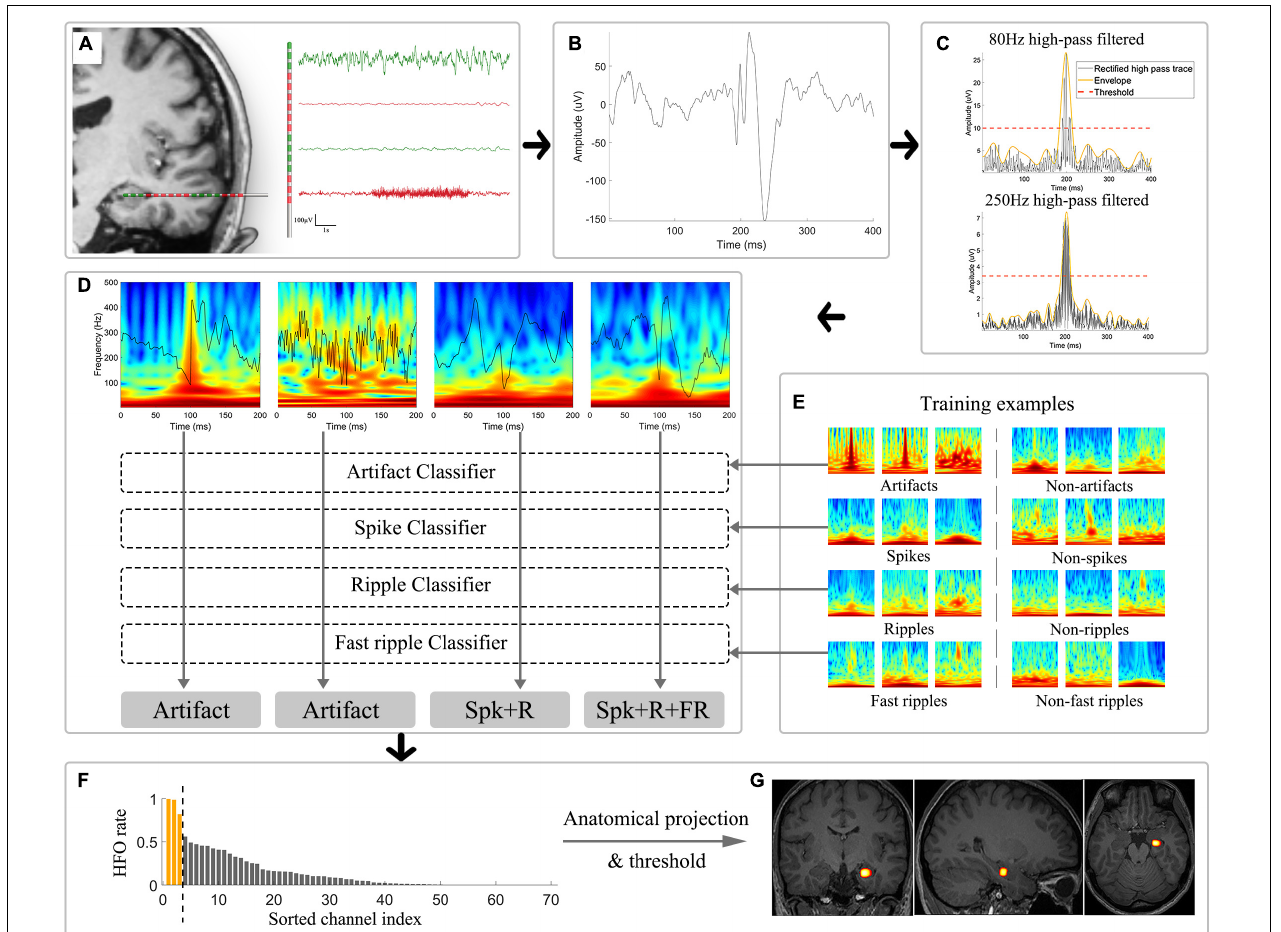
FIGURE 1 | Schematic illustration of the automatic analytical strategies. (A) Channel selection was performed to exclude electrodes located in white matter, showing low-amplitude fluctuation and located outside brain (plotted in red). (B) Example of an unfiltered bipolar signal in a 400 ms window. (C) Signals were independently subjected to 80 and 250 Hz high-pass filters and were then rectified (black trace) for envelope extraction (yellow trace). Thresholds (red trace) were calculated based on the envelopes. Candidate HFOs were extracted by identifying envelopes surpassing the corresponding threshold of each channel. (D) Morlet wavelet transform was applied to convert the epoched candidate HFO time series to time-frequency domain images, which were further used as input for the CNN classifiers. (E) Example training and validation dataset used for the four binary CNN classifier training. (F) HFOs sorting based on the occurrence rate. The yellow bar suggested the application of thresholding in HFOs occurrence rate that would be overlaid on the anatomical image. (G) The results were then projected to the anatomical structures and shown as a heatmap illustrating the distribution of high-occurrence HFOs. CNN: convolutional neural network; HFOs: high frequency oscillations; Spk: spike; R: ripple; FR: fast